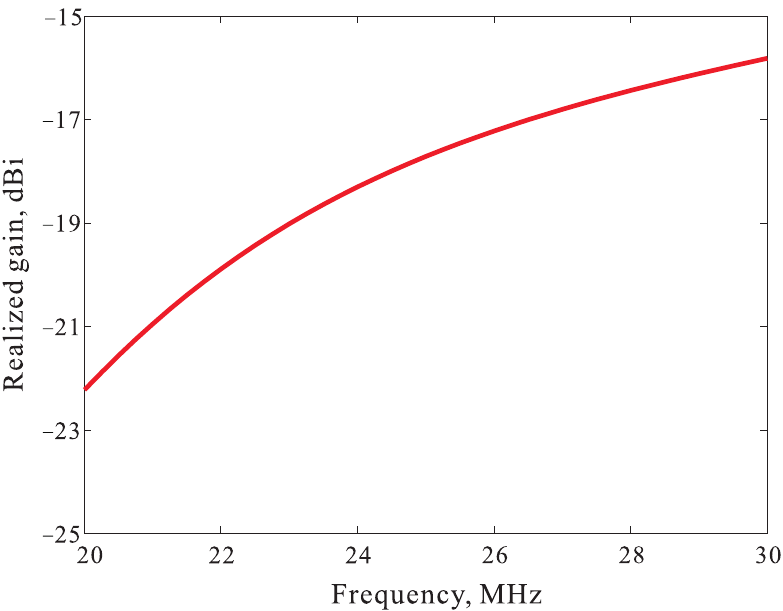
Figure 10. Simulated realized gain on the + z -axis of the meandered dipole antenna with the